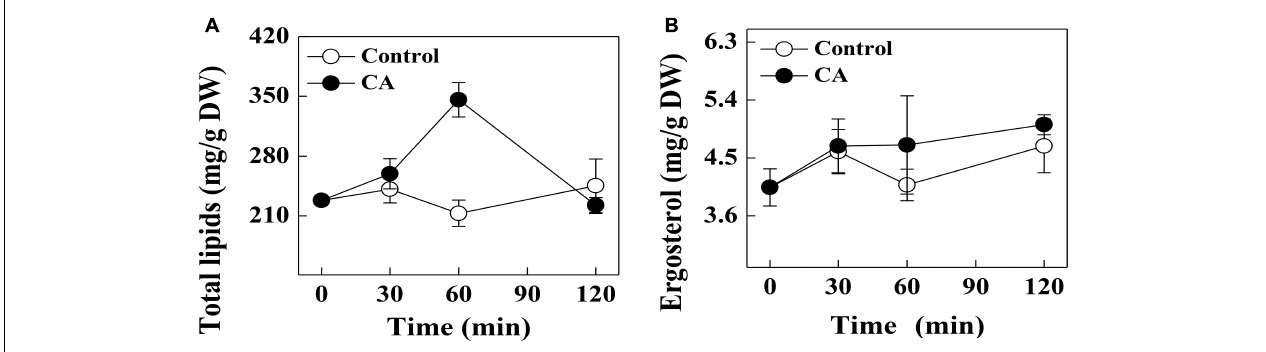
FIGURE 3 | Effects of CA on (A) the total lipids contents and (B) ergosterol contents of G. citri-aurantii mycelia. The data presented are the means of pooled data. Error bars indicate the SDs of the means ( n = 3).